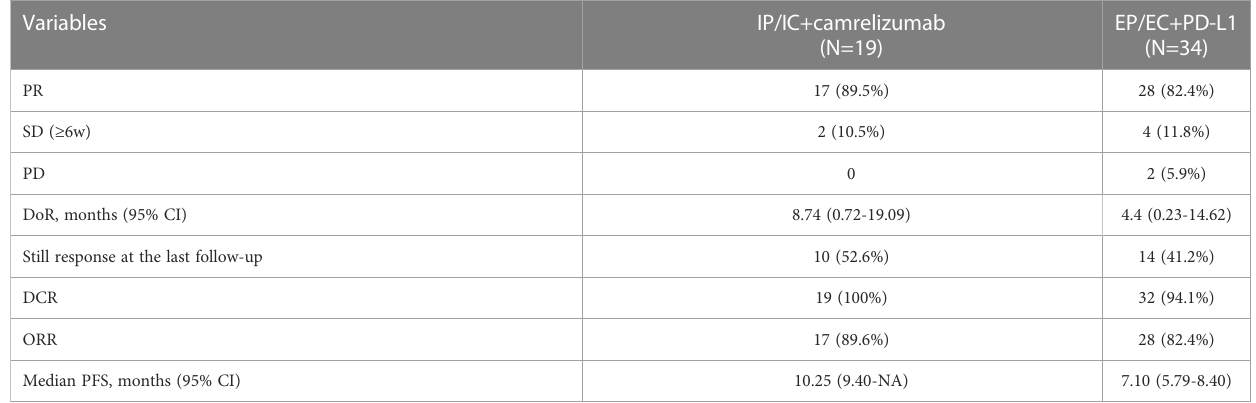
TABLE 2 Treatment ef fi cacy.